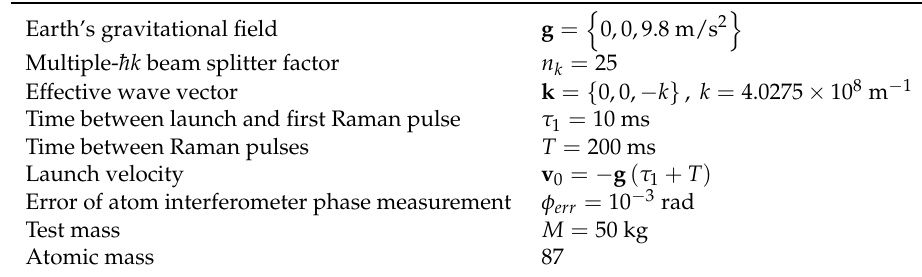
Table 1. Parameters of the atom interferometer and gravitational